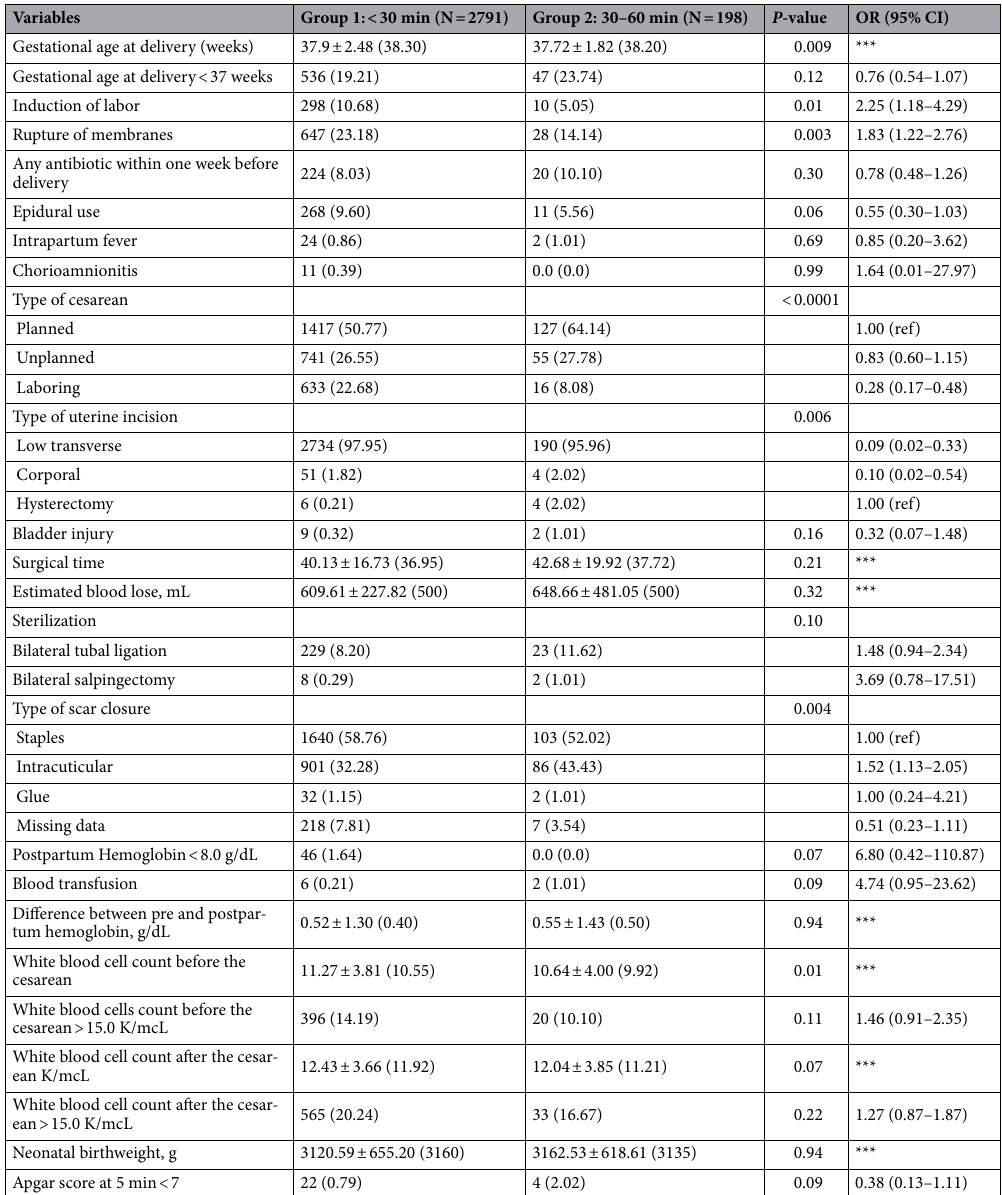
Table 2. Peripartum variables of women who received prophylactic antibiotic within 30 compared with 30–60 min before skin incision. Data are mean ± standard deviation (median) or N (%) unless otherwise